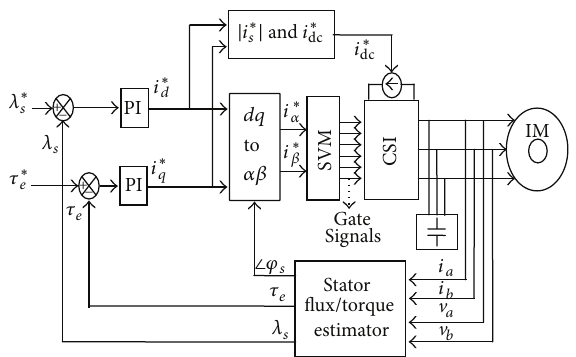
Figure 11: Block diagram schematic of the proposed DTC.